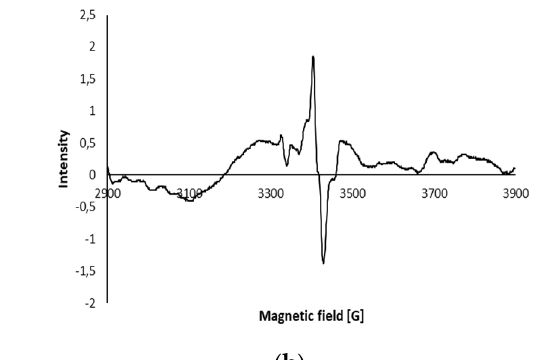
Figure 1. Electronic spin resonance ( ESR) spectrum of original deionized, non-treated water containing dissolved air ( a ) and WTS ( b ) after the 15 min treatment.